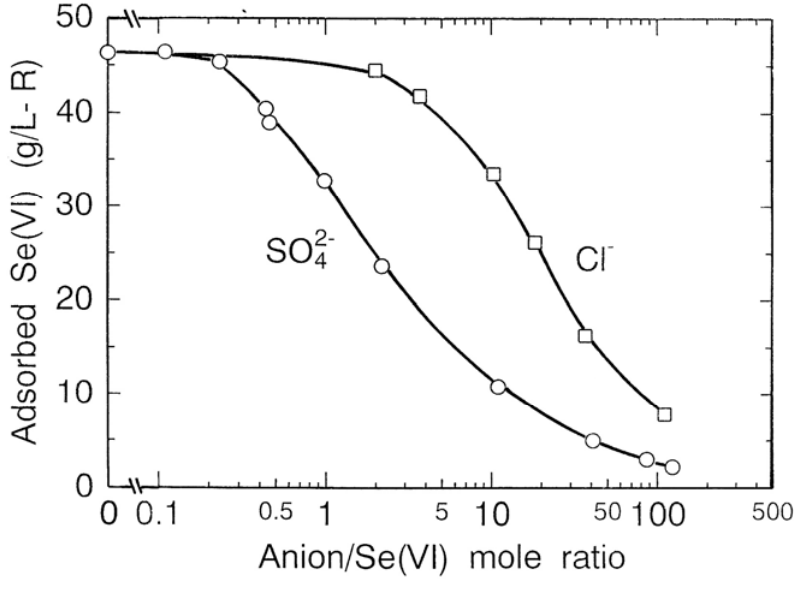
Figure 17. Effect of coexisting anion on adsorption of selenium(VI) on